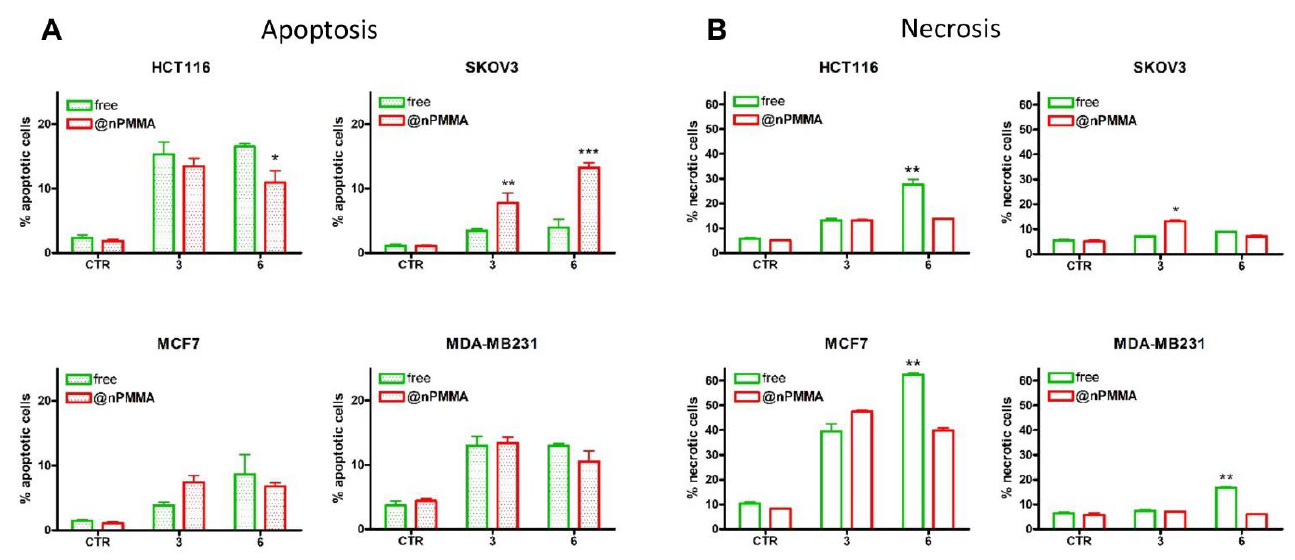
Figure 5. Percentage of apoptotic ( A ) and necrotic ( B ) HCT116, SKOV3, MCF7 and MDA-MB231 cells following 24 h treatment with free (green) or nPMMA-bounded (red) 3 and 6 , 1h irradiation and 24 h incubation in drug-free medium (mean ± SE of 3/4 independent experiments; * p < 0.05, ** p < 0.01 and *** p < 0.001 vs. respective free-BODIPY).